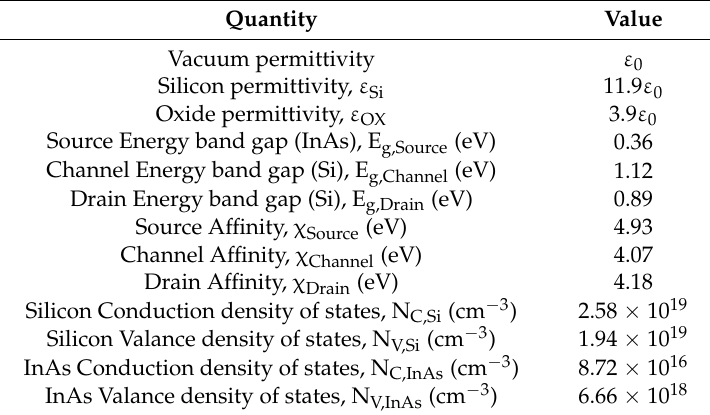
Table A2. Material parameters used in this